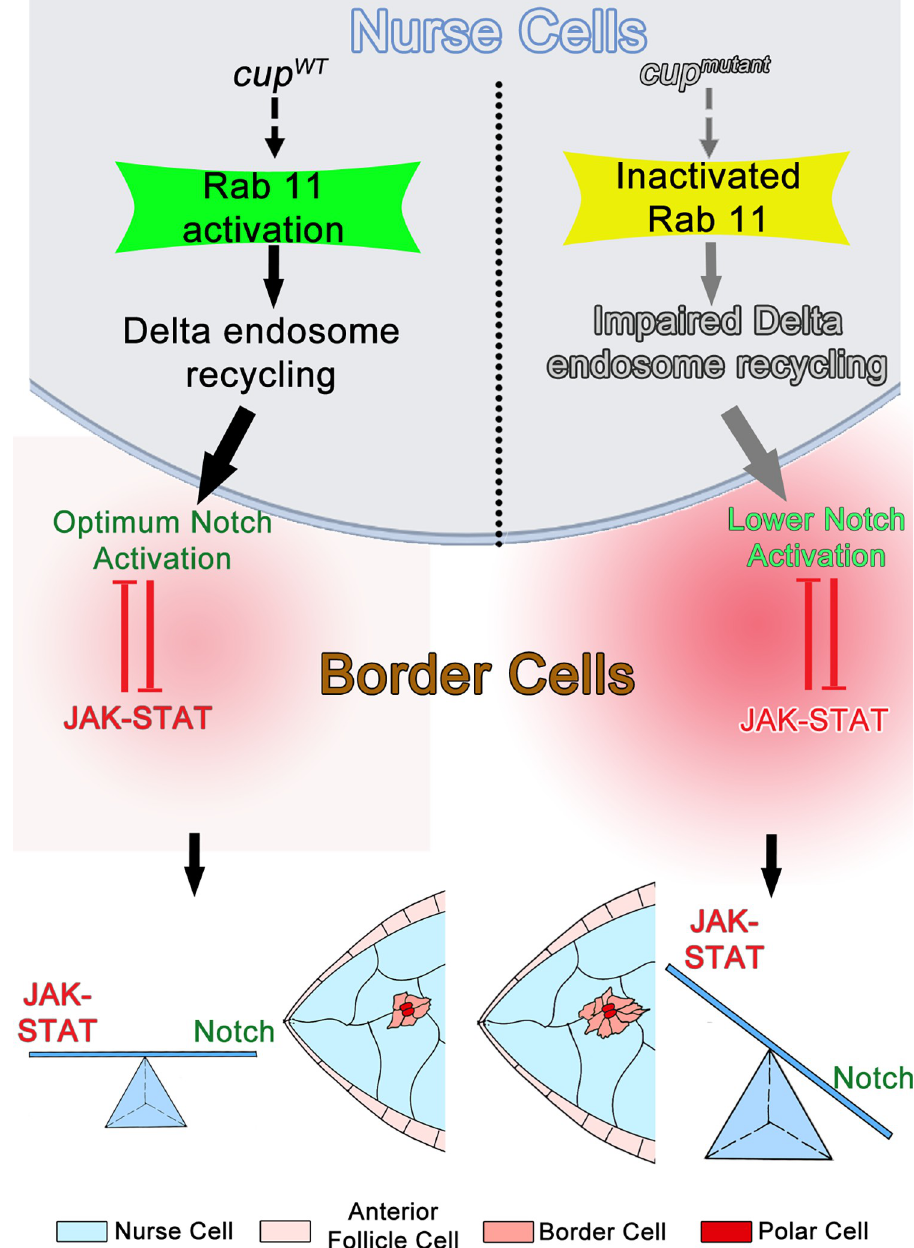
Fig 8. Schematic of Proposed Model. Cup function potentiates Delta recycling in the germline nurse cells. This stimulates non-cell autonomous activation of Notch signaling in the Anterior Follicle cells (AFCs). As Notch and JAK-STAT are antagonistic, a balance between these two signaling cascades aids in transformation of an optimum number of stationary AFCs to migratory border cell fate. In the cup mutants, Notch signaling is impeded, which results in higher levels of STAT and larger number of AFCs acquiring migratory border cell